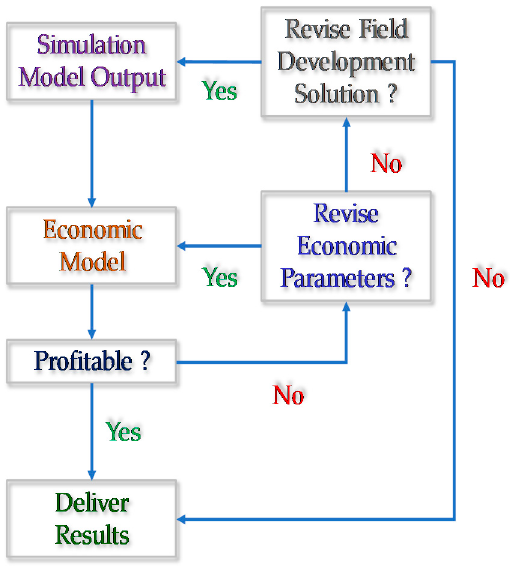
Figure 4. Integrated workflow.